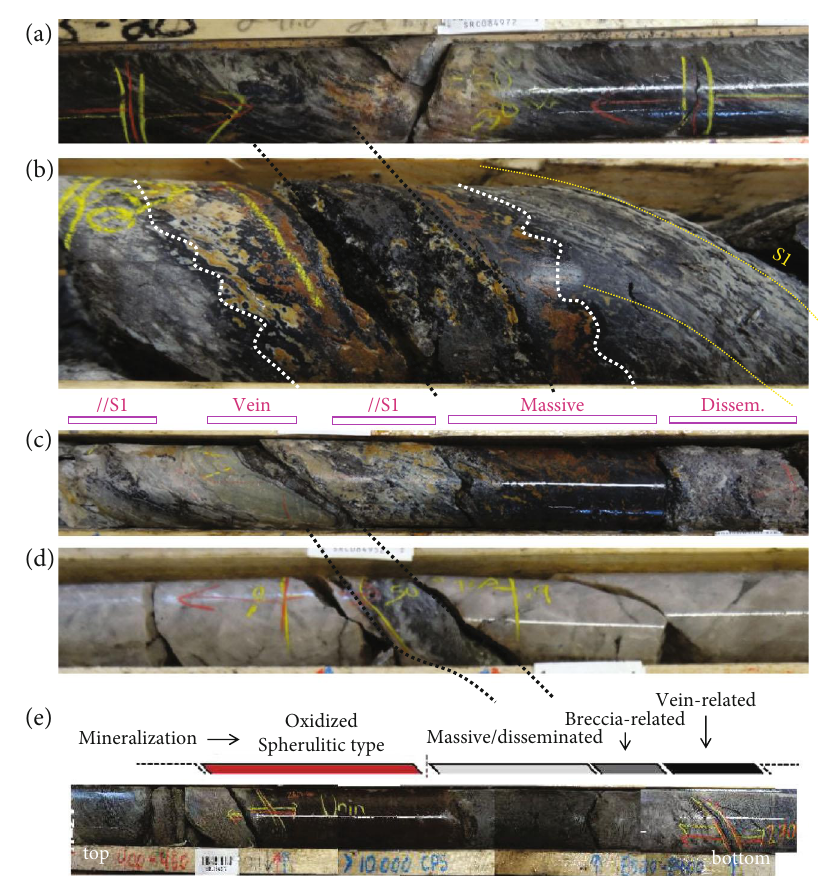
Figure 18: Uranium mineralization in drill hole HK16-43: (a) parallel to foliation mineralization, (b) vein-related mineralization crosscutting foliation, (c) disseminated in cataclastic gouges to massive as vein cement, (d) mineralized vein through a quartz vein, and (e) high-grade mineralized interval in drill hole